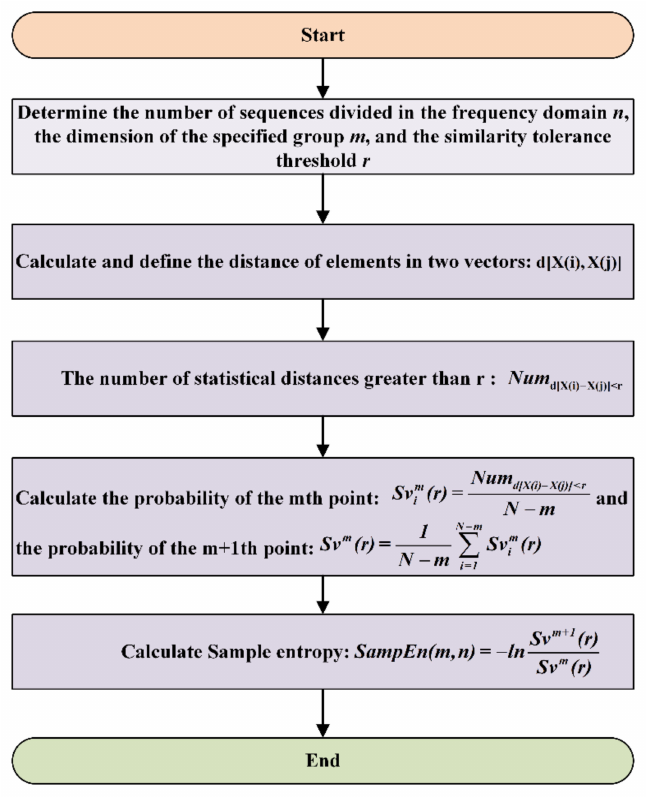
Figure 1. Frequency domain sample entropy calculation flow diagram.